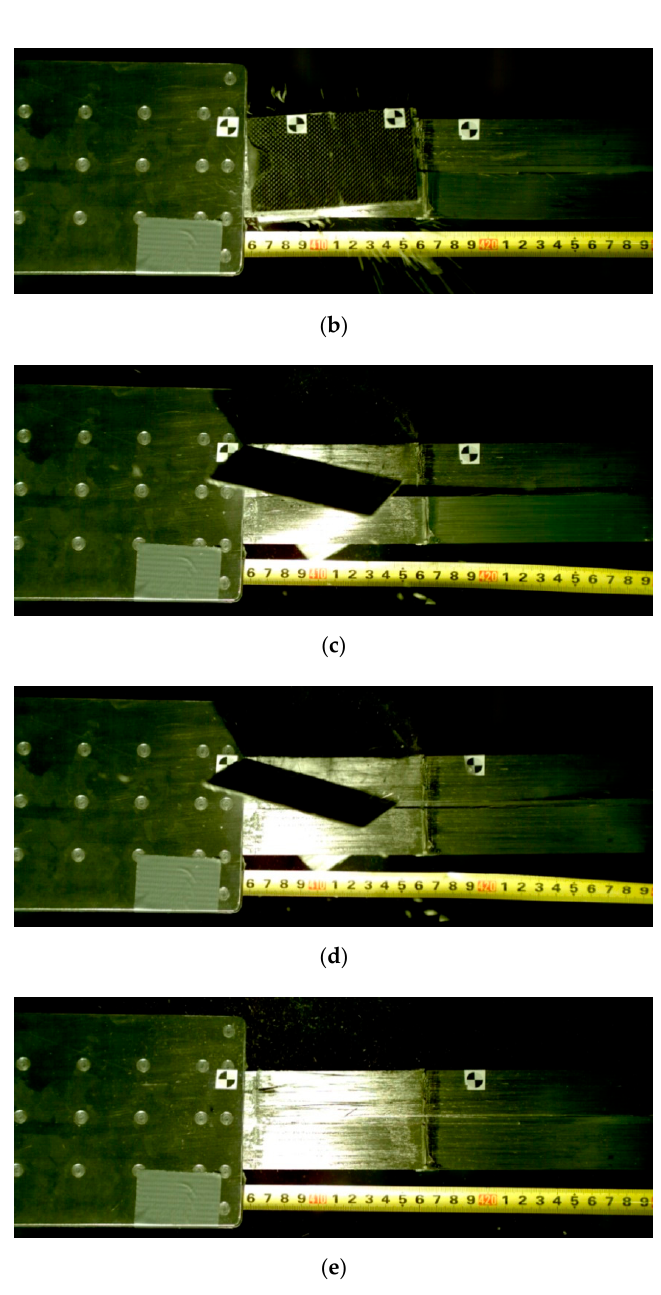
Figure 18. Sequence of failure of specimen P3/S3N: ( a ) Specimen directly before failure, ( b ) longitudinal shear cracking and bottom part of the strip slipping out, resulting in carbon fiber overlay delamination, ( c ) specimen directly before the upper part of the strip slipping out, ( d ) upper part of the strip slipping out, ( e ) specimen after